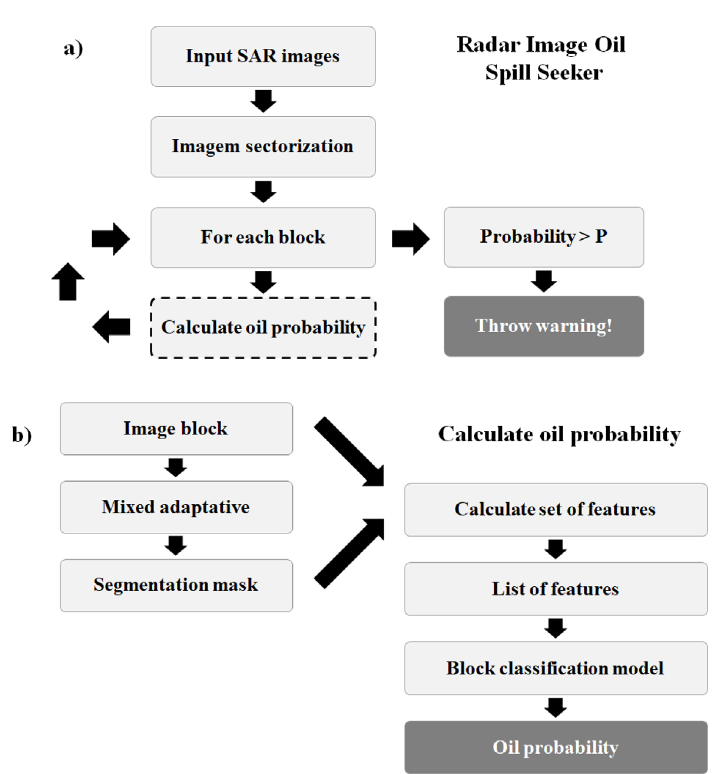
Figure 3. Flowchart of the proposed methodology based on the RIOSS algorithm (Adapted from Conceição et al.